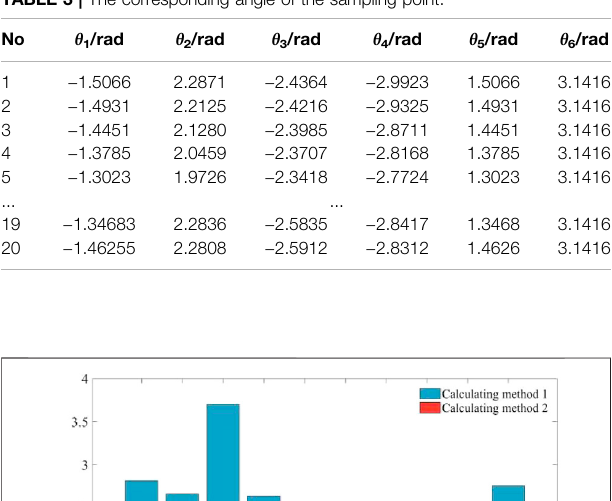
TABLE 3 | The corresponding angle of the sampling point.